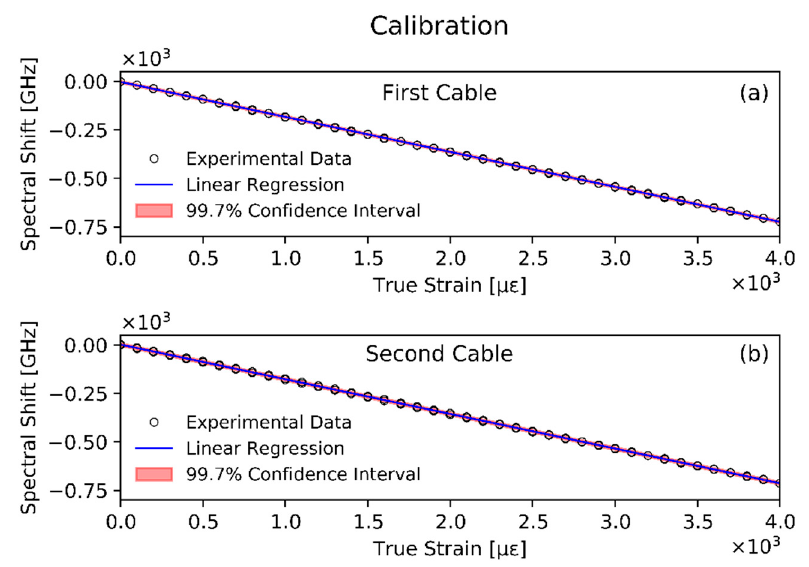
Figure 5. Calibration data for the first ( a ), and the second ( b ), cable prototypes.